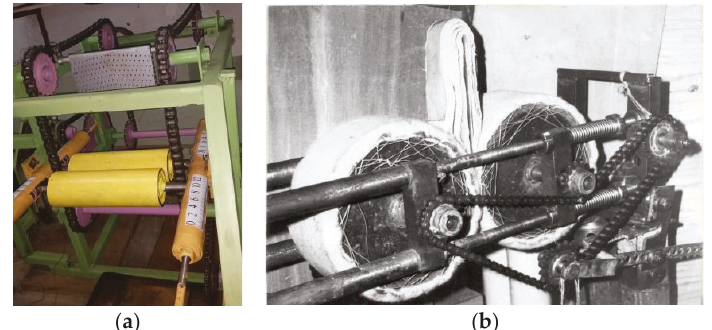
Figure 4. A stand for wringing moisture from a multiple skin sandwich with the vertical feed on the base plate ( a ). A detailed view of the stand ( b ).